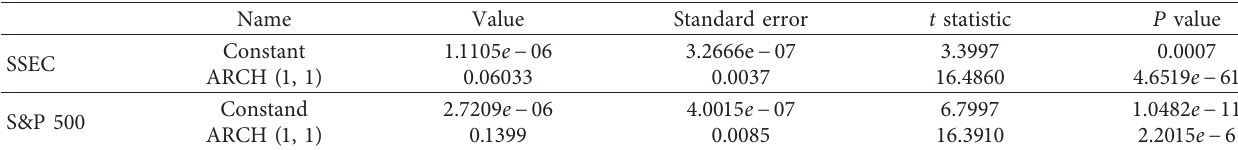
Figure 2: Monthly GEPU, AEPU, and CEPU indices. (a) Global EPU. (b) American EPU. (c) Chinese EPU. Table 3: ARCH test results for the SSEC index and S&P 500 index